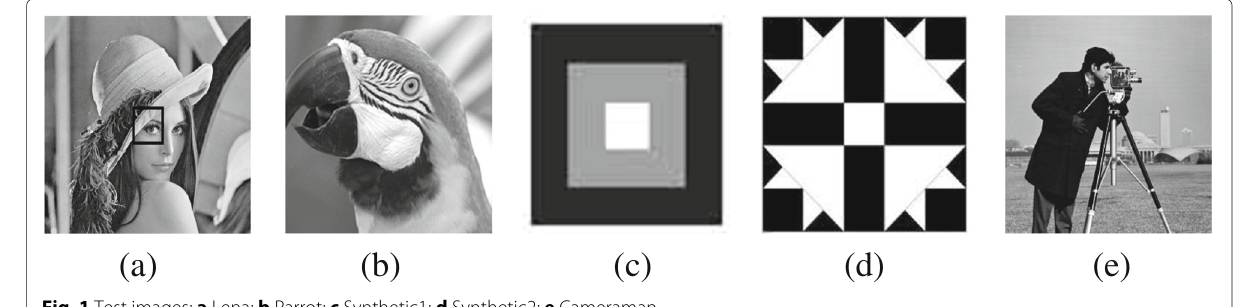
Fig. 1 Test images; a Lena; b Parrot; c Synthetic1; d Synthetic2; e